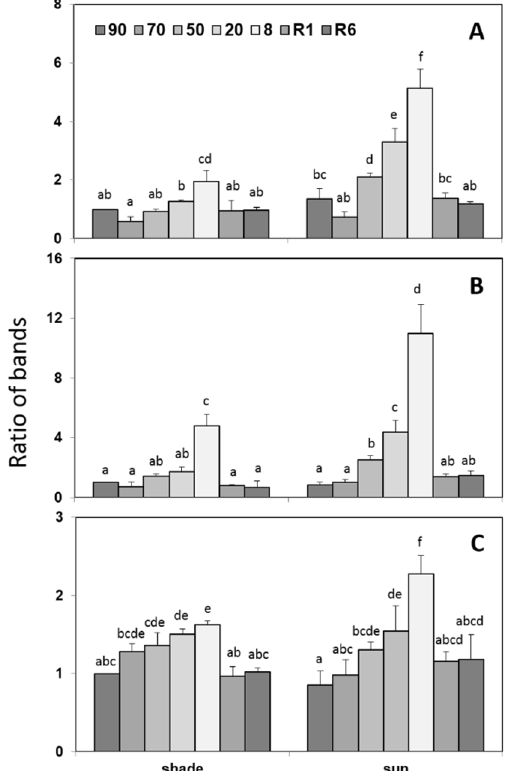
Figure 4. Changes in the density of leaf dehydrin bands 0 ( A ), 1 ( B ), and 5 ( C ) in the shade and sun H. rhodopensis plants in controls (90%), during dehydration (70, 50, 20, and 8% RWC) and after rehydration (1 and 6 days of rehydration; R1 and R6, respectively). Amounts of dehydrins were determined by Western blotting and normalized to the same total stained protein values in the lanes. For better comparison of the kinetics of changes in a given polypeptide in the shade and sun leaves, shade control values were chosen as 1. Values are given as mean ± SD ( n = 4). Changes between shade and sun plants were statistically compared. Different letters within a graph indicate significant differences assessed by the Fisher LSD test ( p ≤ 0.05) after performing multifactor